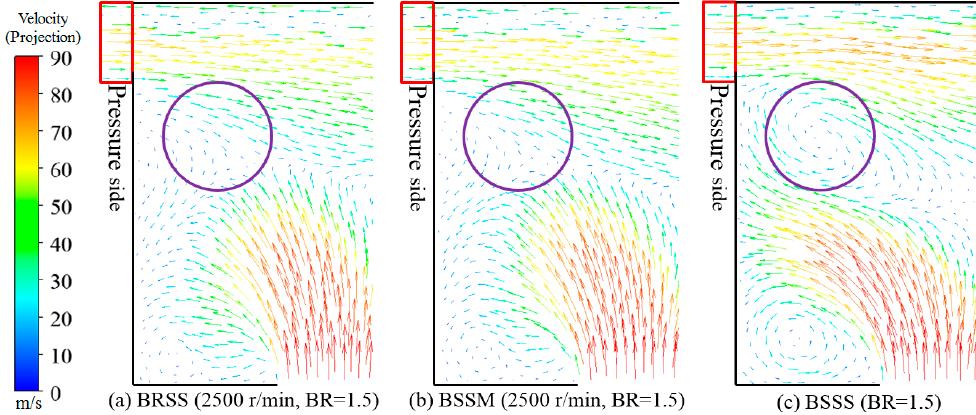
Figure 6. Velocity distributions on cuts 3 and 4 at BR = 1.5 ( a ) BRSS; ( b ) BSSM; ( c ) BSSS.